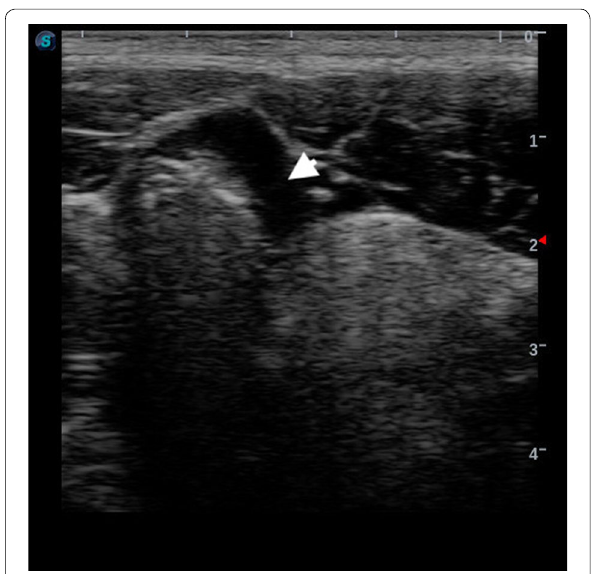
Fig. 1 Positive SSLOW Exam. Positive SSLOW exam with free fluid in the bowel interloops. The patient had a penetrating wound to the right lower quadrant and was found to have an injury to the cecum on exploratory